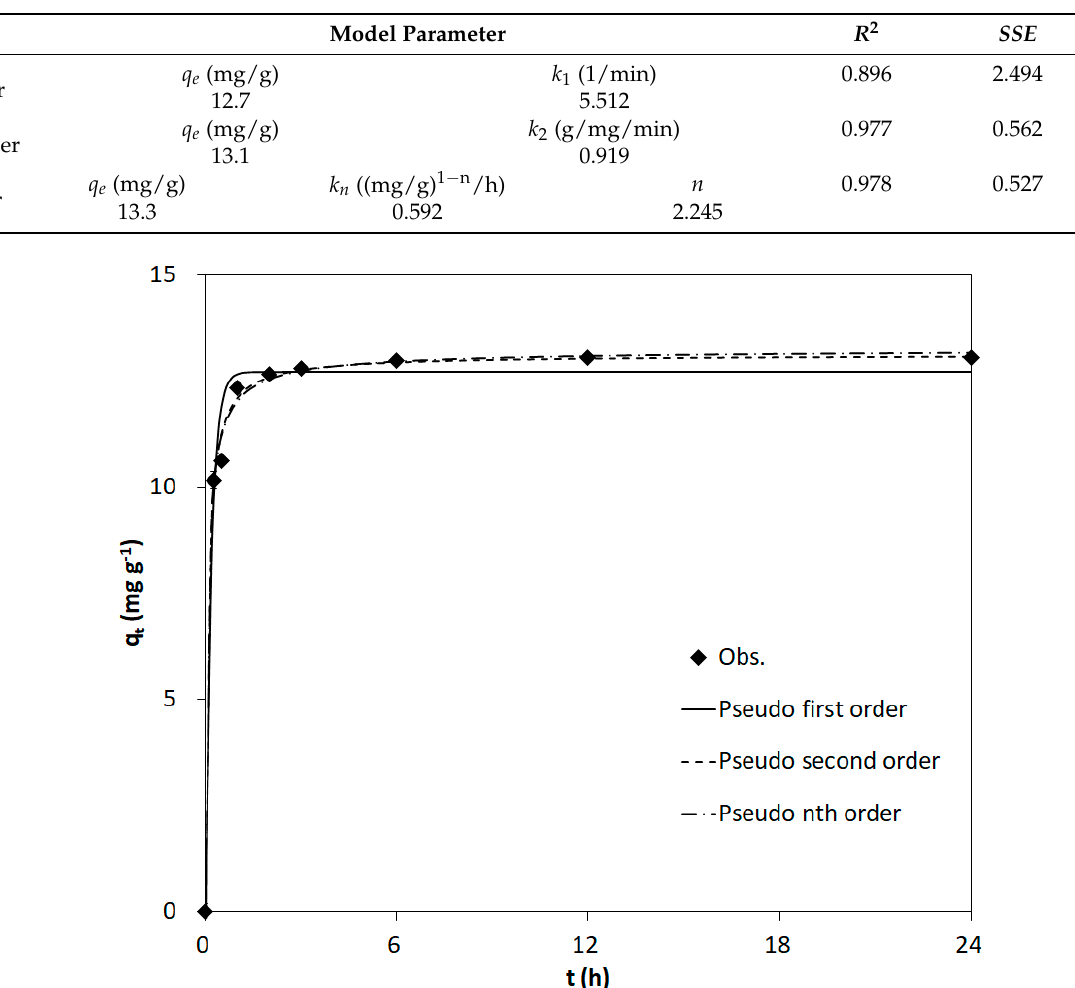
Table 2. Model parameters and model suitability for kinetic adsorption data obtained from pseudo-first-order, pseudo- second-order, and pseudo-nth-order models.